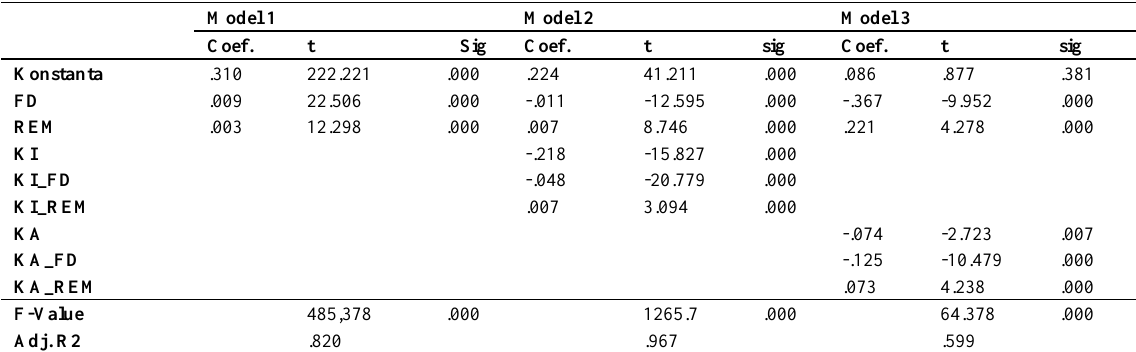
Table 3: Multiple Linear Regression